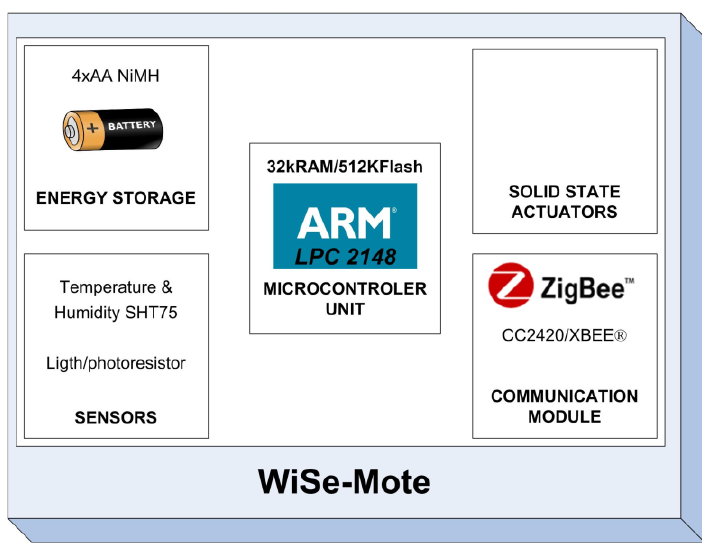
Figure 2. Model of the Open-WiSe